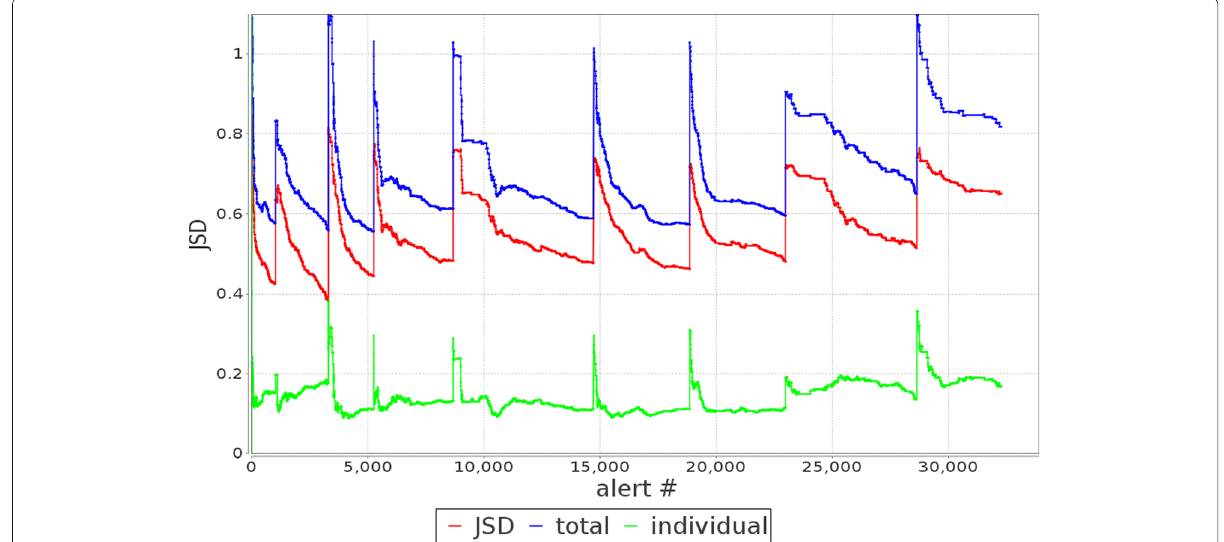
Fig. 5 The JSD f (JSD), E T